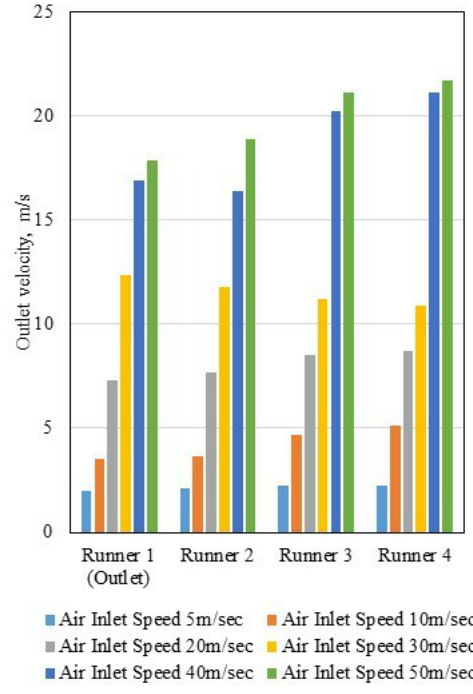
Fig. 10. Comparison between air intake velocity and runners at steady state analysis